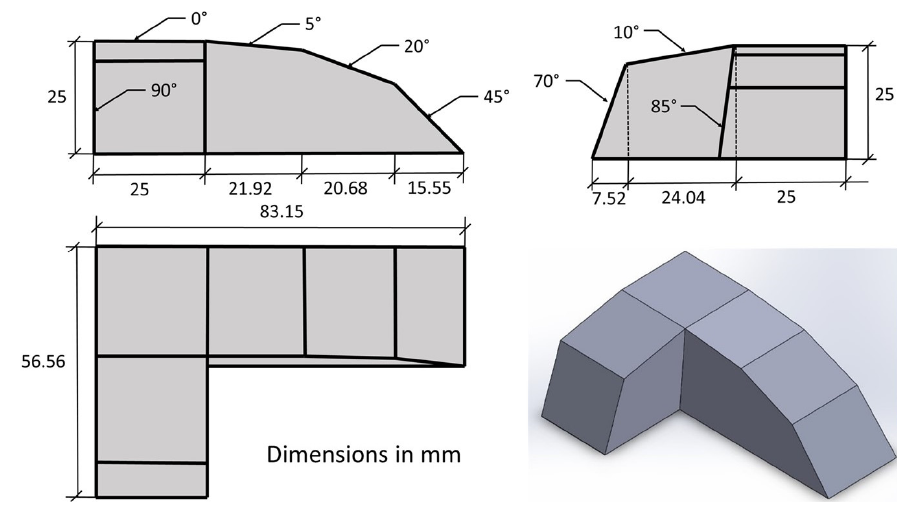
Figure 2. Specimen design with dimensions.